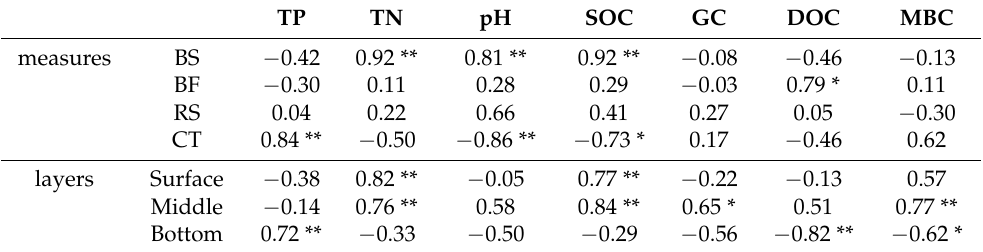
Table 3. Pearson correlations between fungal ITS rRNA gene copy number and soil properties under different soil and water conservation measures. Asterisks indicates significant correlation (** p < 0.01, * p <